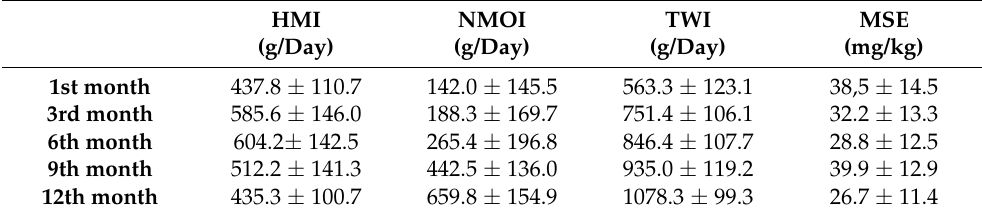
Table 2. Average intake (g/day) of human breast milk, water from sources other than breast milk and total water intake during the study